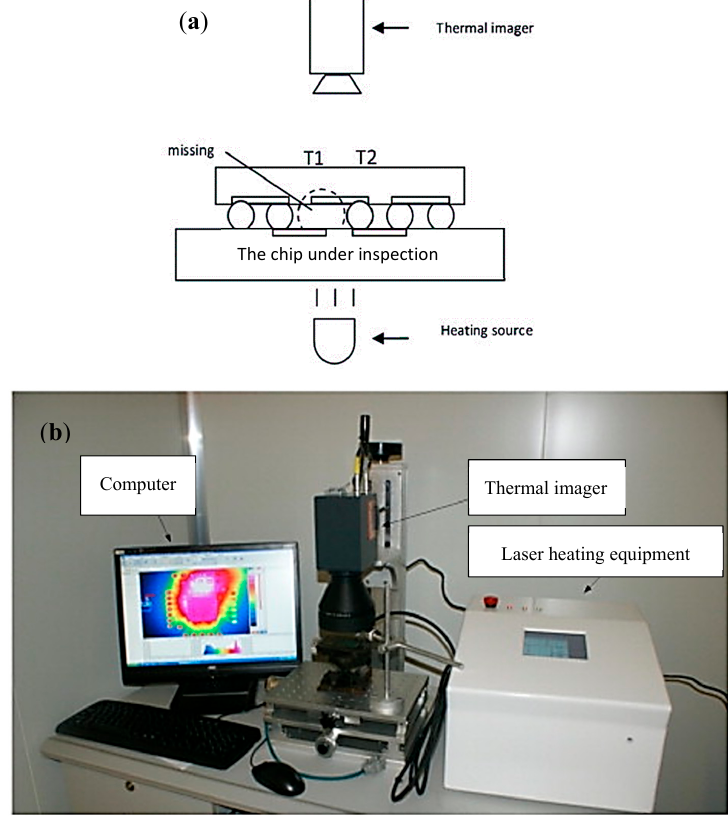
Figure 13. A represetative experimental setup for inspection of solder bumps using IRT method, ( a ) the inspection procedure, and ( b ) the different parts of the experimental setup [33].